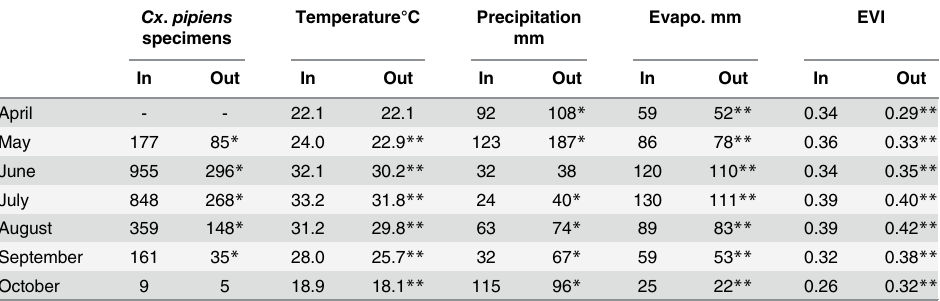
Table 2. Monthly average of Culex pipiens specimens, temperatures, cumulative precipitation, evapo- transpiration (Evapo.), and enhanced vegetation index (EVI) value inside and outside the WNV-circu- lation area estimated by KDE, * p < 0.05 ** p < 0.01 according to a Kruskal-Wallis test. The standard deviations and number of observations are reported in S2